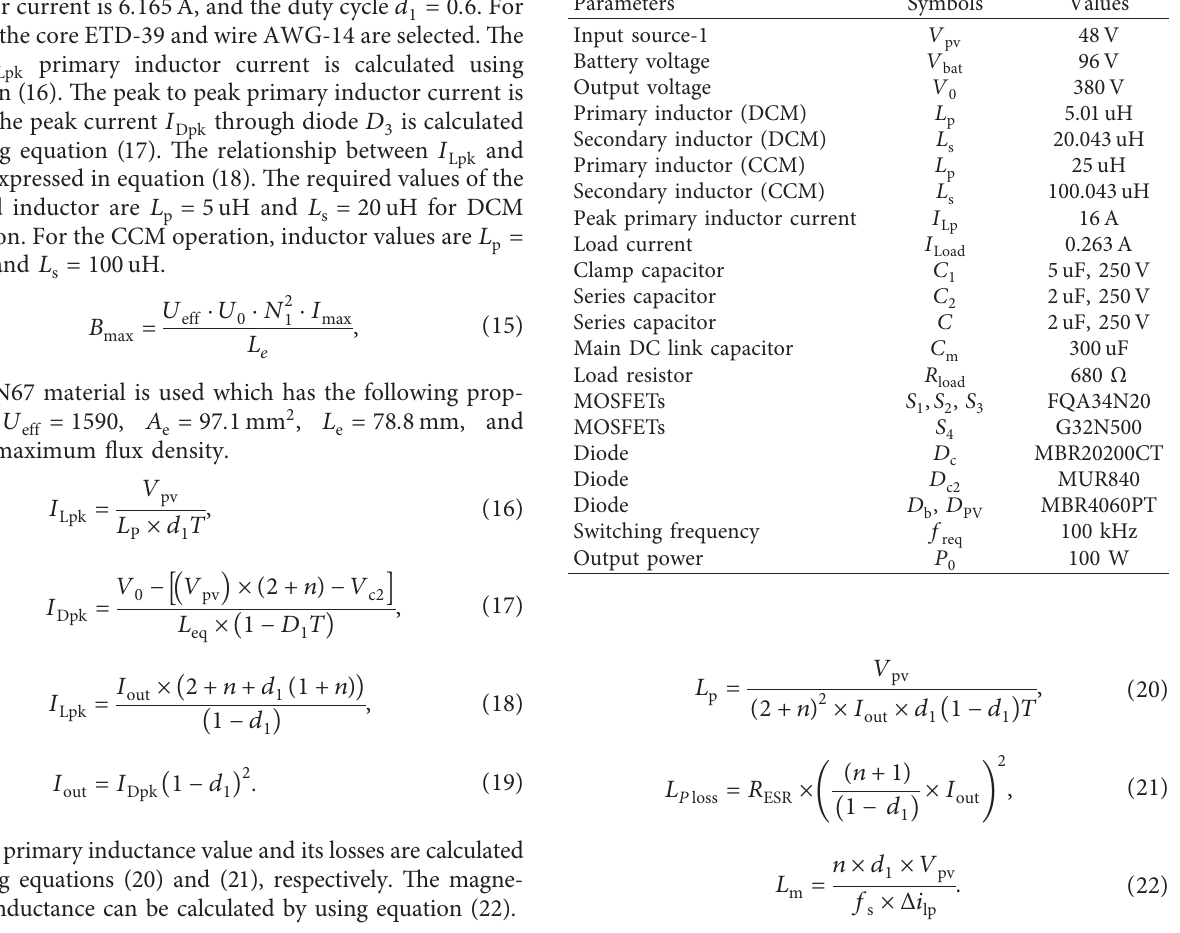
) in SISO mode. (b) Output vs input voltage in SISO mode with different values of “ n 1